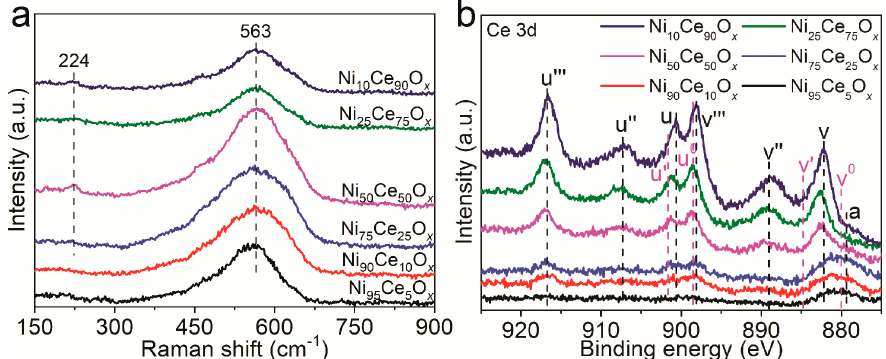
Figure 3. ( a ) Raman spectra and ( b ) XPS spectra of Ni y Ce 100 − y O x samples. The peak labeled a in the XPS spectra is ascribed to the Ni 2p peak.